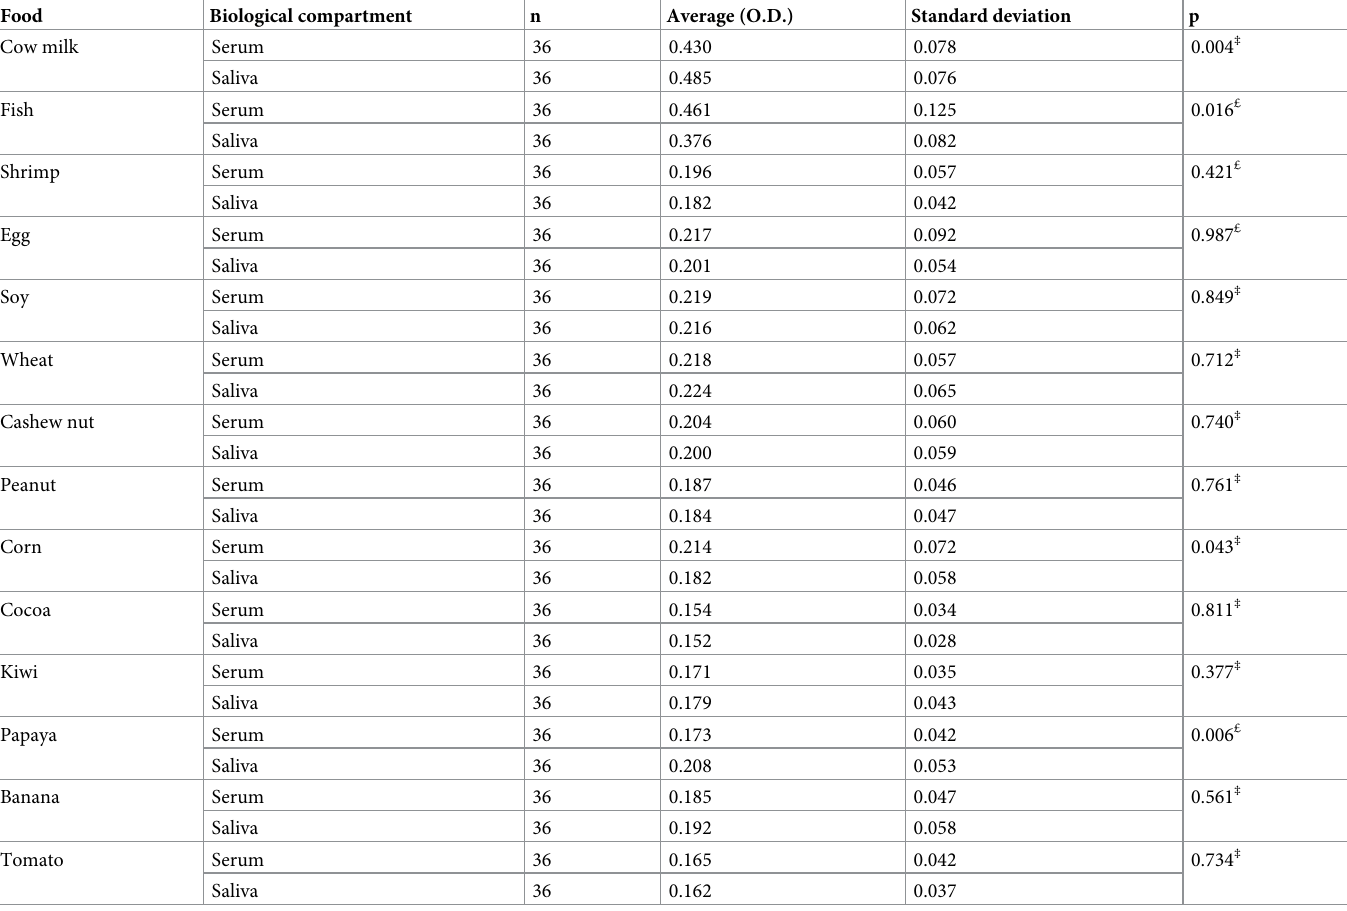
Table 5. Comparison of IgE concentration between serum and saliva in each food.